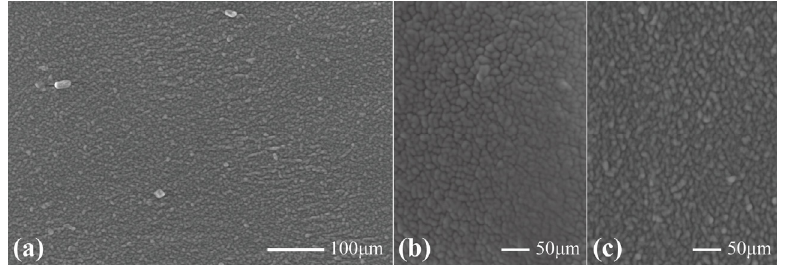
Figure 7. Scanning electron microscope images for 1:8 and 1:9 weight ratios of CB:Ecoflex. Images for 1:8 weight ratio magnified at ×250 ( a ) and ×450 ( b ), and 1:9 weight ratio magnified at ×450 ( c ). The 1:8 weight ratio had the lowest change in resistance under cyclic stretching. This